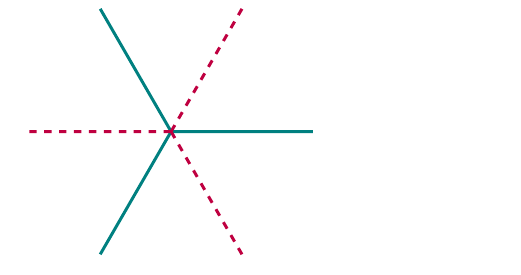
Figure A.10: Horizontal (solid line) and vertical (dashed) trajectories near a zero of order one q = z ( dz ) 2 .